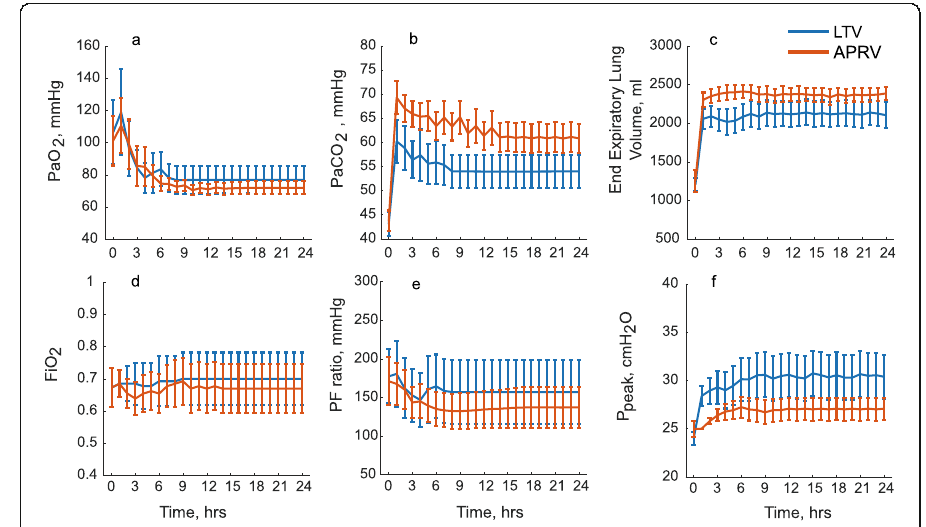
Fig. 2 Graphical results for hourly changes in arterial partial pressures of a oxygen, b carbon dioxide, c end expiratory lung volume, d inspired concentration of oxygen, e PF ratios, and f peak ventilatory pressures (P peak ). The LTV arm is represented in blue and the APRV arm is in